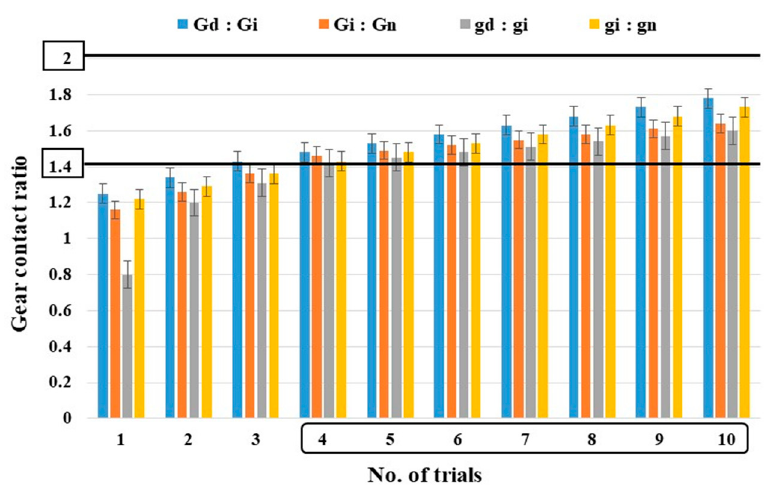
Figure 6. Gear contact ratio of primary and connecting links.